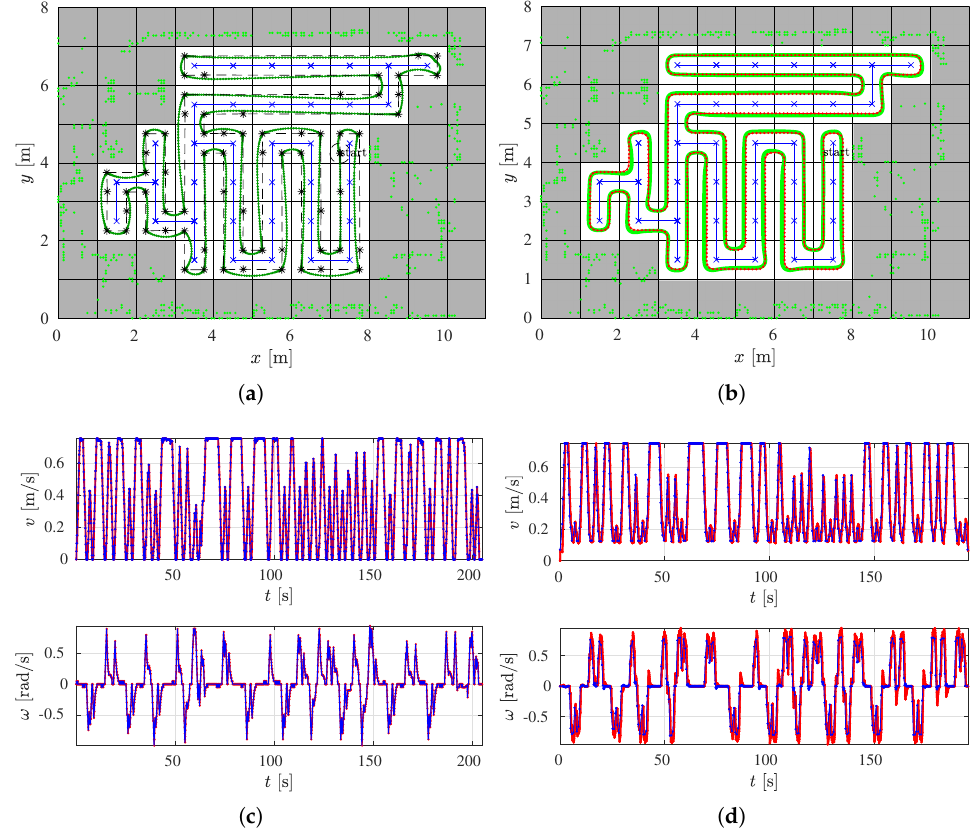
Figure 8. The comparison of the CCPP and SCCPP algorithms in the Lab scenario with the presented RSTC spanning tree (blue line), the RSTC path (black line), the smoothed path by the SCCPP algorithm (red line), the executed path by the CCPP and SCCPP algorithm (green line), the reference velocity profile (blue line), and the actual velocity profile (red line). ( a ) The CCPP path in the Lab scenario . ( b ) The SCCPP path in the Lab scenario . ( c ) The CCPP velocity profile in the Lab scenario . ( d ) The SCCPP velocity profile in the Lab scenario